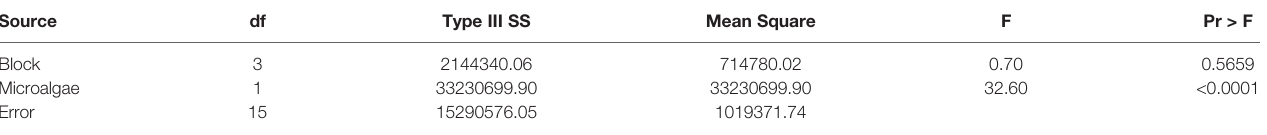
TABLE 2 | GLM (RMANOVA) table summarizing analysis of FR of the pleated tunicate Styela plicata by microalgae treatments of the brown tide-forming pelagophyte Aureococcus anophagefferens , and control species Tisochrysis lutea (Experiment 2). Source